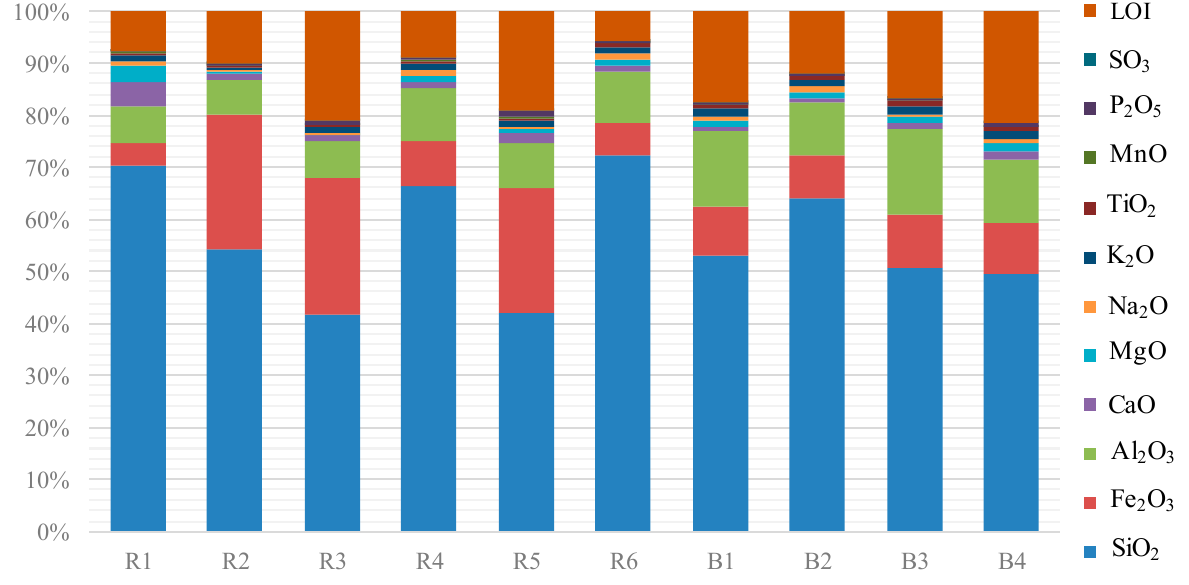
Figure 6. Chemical composition of sediments from the study area. Table 5. Distribution of TE in sediments of the Kosva River and the Kosva Bay, (mg/kg). Kosva River ( n =